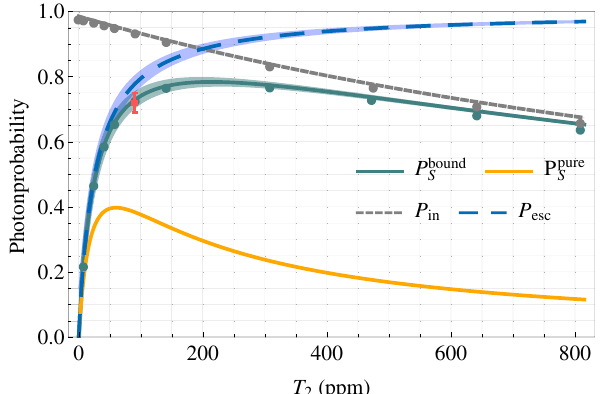
FIG. 7. Predicted photon probabilities in our system as a func- tion of the output-mirror transmission T 2 . The probability for obtaining a photon in the output mode of the cavity P S = P esc P in results from the product of the probability for photon emission into the cavity P in and escape probability P esc . Lines: analytical and P pure are calculated via Eq. (1) calculations, where P bound S S ) for the experimental configuration shown in ( j = 0 for P pure S Fig. 2 and the parameters given in Appendix A 2. Shaded areas and P esc represent the uncertainties in the mea- around P bound S sured cavity parameters. Red dot with error bars: experimentally ; error bars are due to the uncertainty measured efficiency P exp S in the efficiency of detector and photon path. Dots: